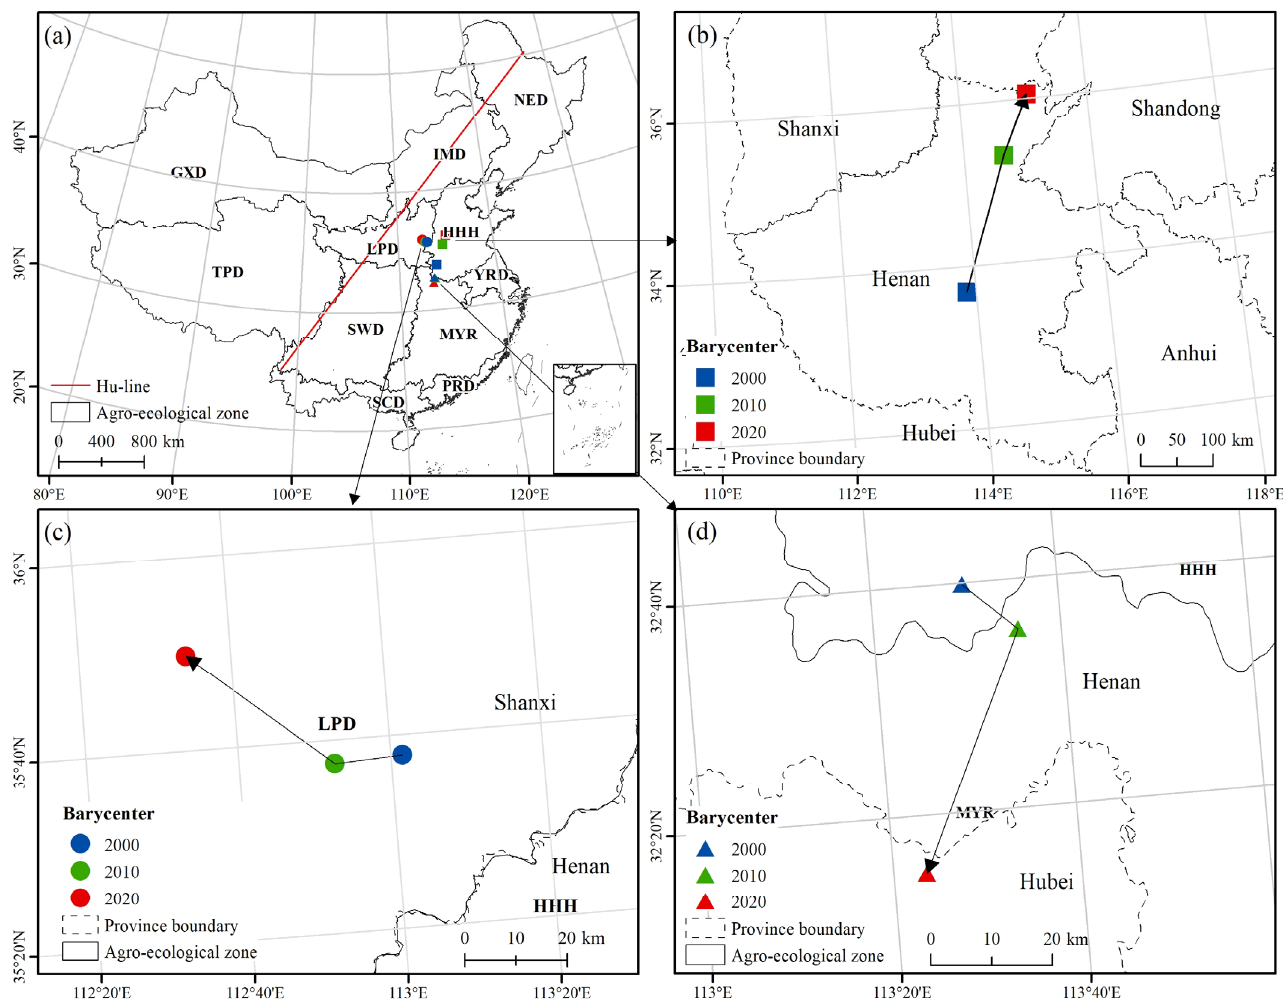
Figure 3. ( a ) The moving trajectory of barycenters of China’s cropland area, grain production, and population over the past two decades. ( b – d ) represent cropland area, grain production, and popu- lation, respectively. Table 2. Moving distances and directions of